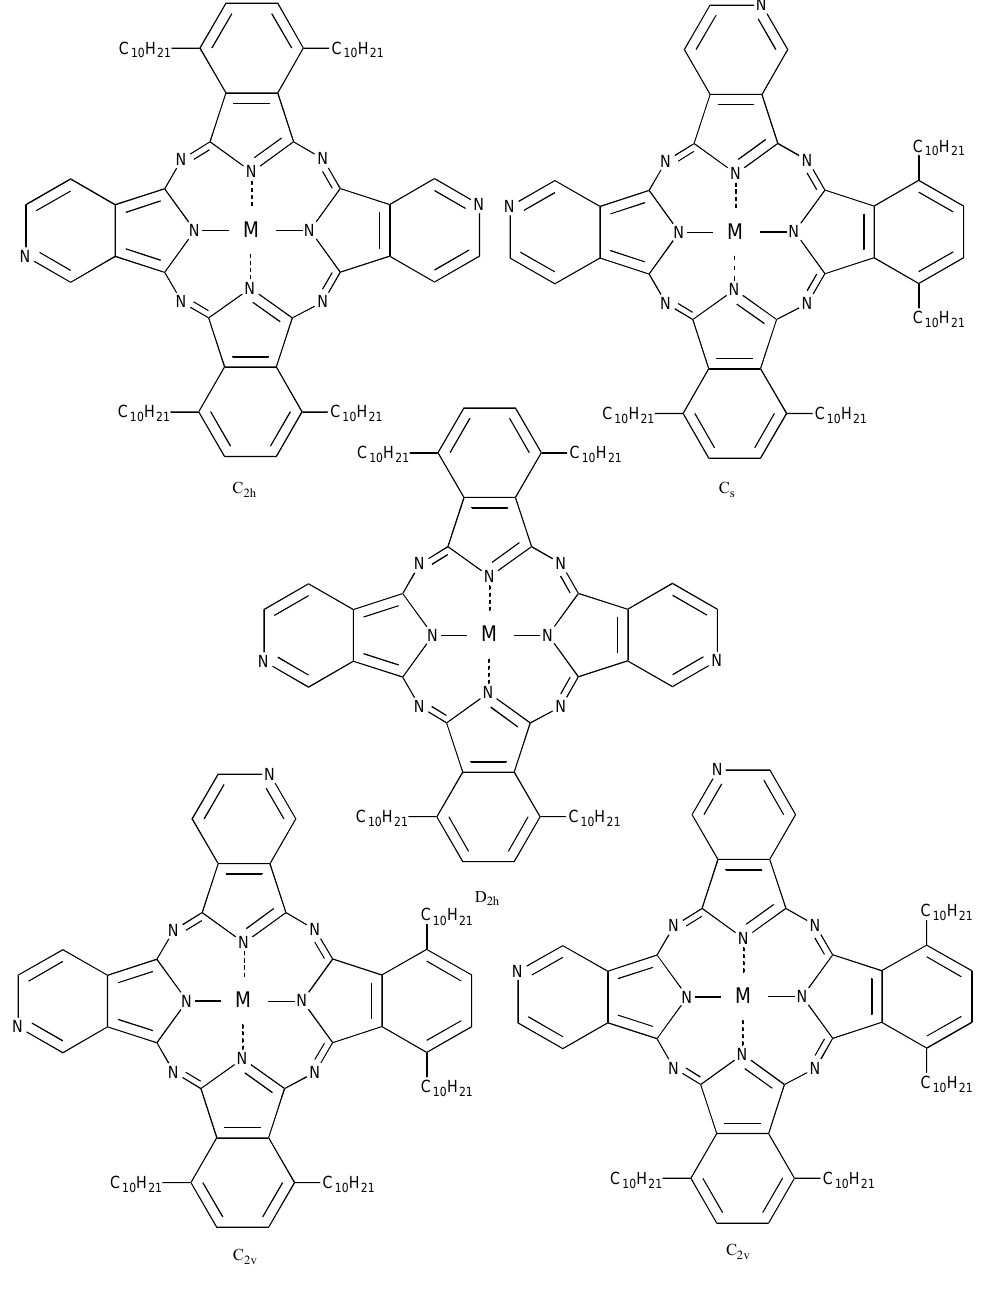
Figure 2. Regioisomers of metal bis(1,4-didecylbenzo)-bis(3,4-pyrido)porphyrazine 5c